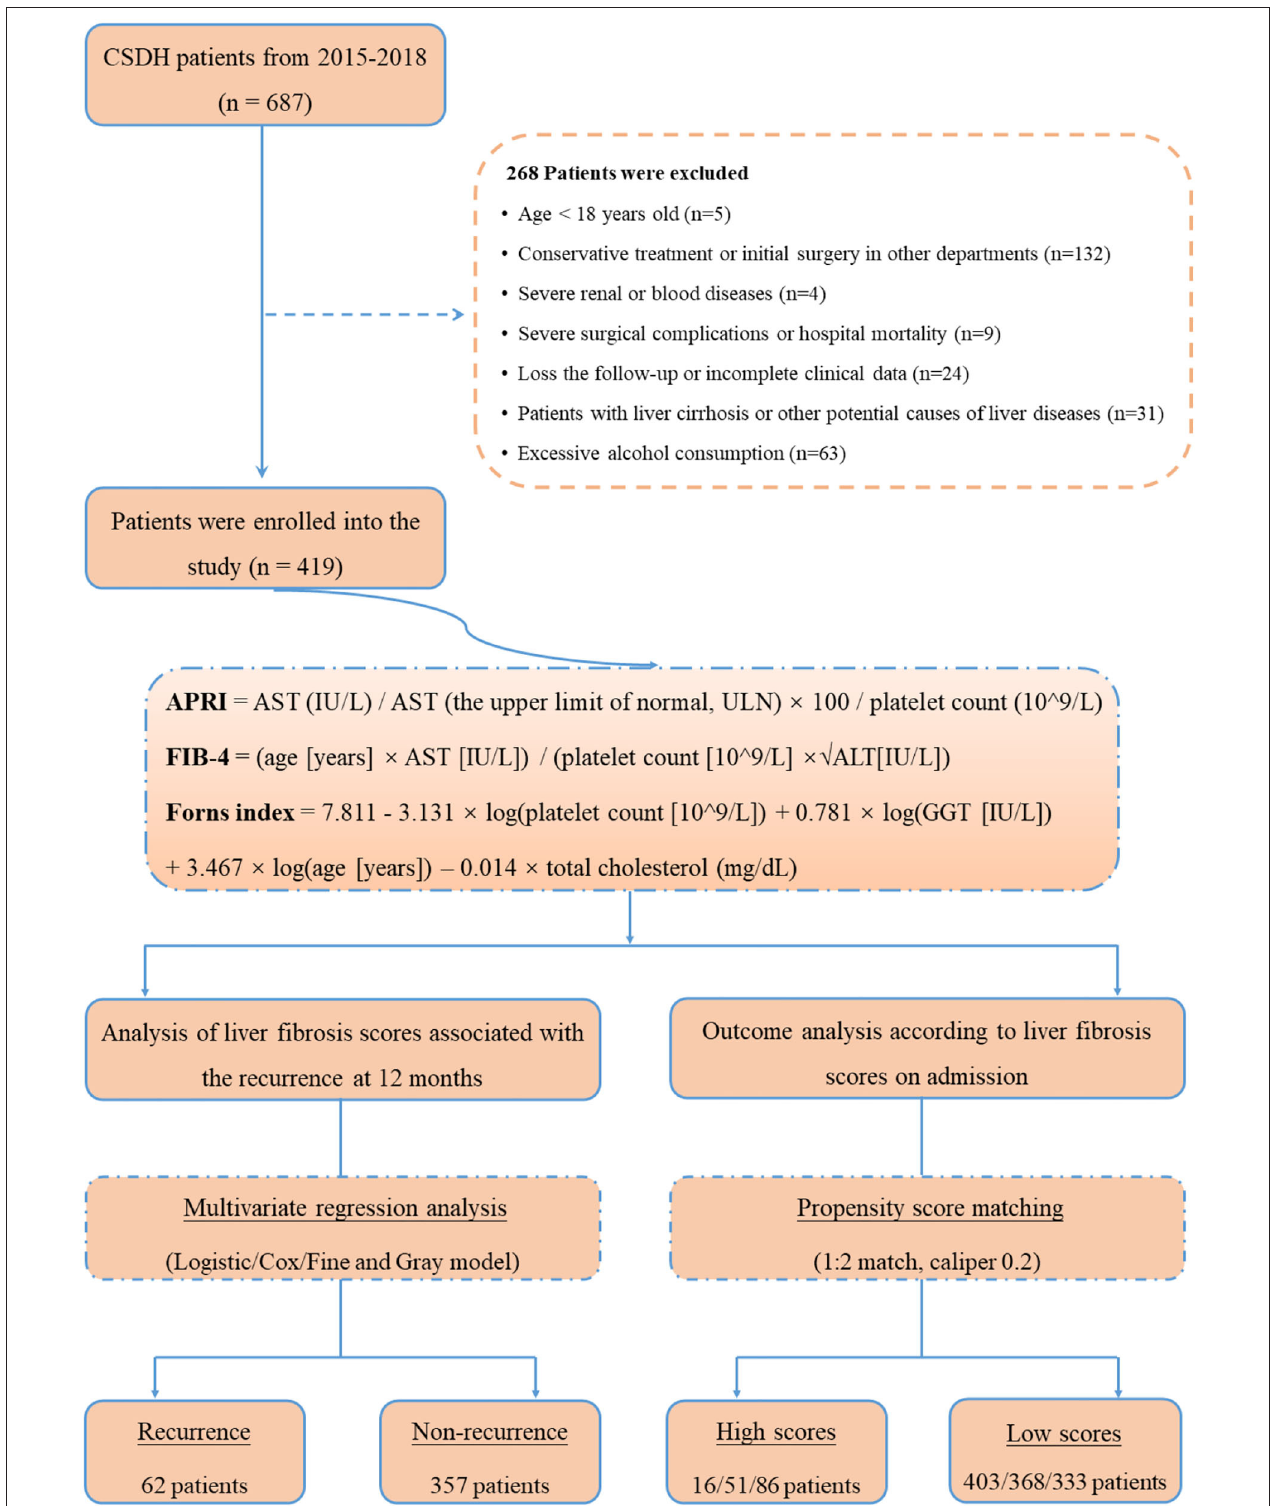
FIGURE 1 | Flowchart of detailed design for the